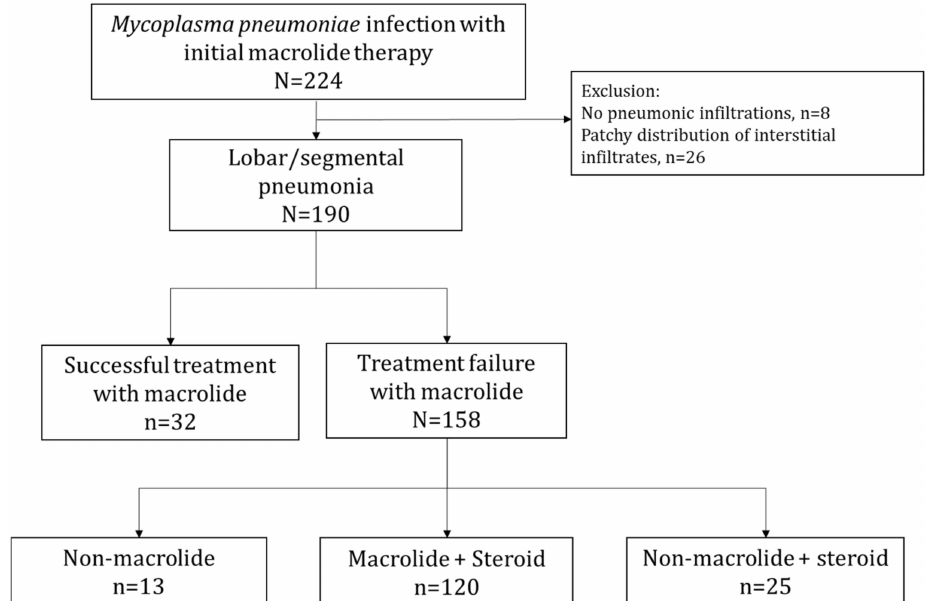
Figure 1. Flow chart of patients included as study participants. Patients were divided into three treatment groups depending on the alternative regimen administered after the initial macrolide ther- apy: 8.2% ( n = 13/158) were switched to a non-macrolide (doxycycline, n = 13), 75.9% ( n = 120/158) were administered macrolide + steroid, and 15.8% ( n = 25/158) were switched to a non-macrolide (doxycycline, n = 21; levofloxacin, n = 4) +